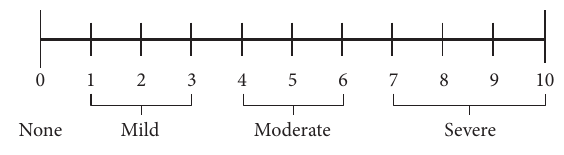
Figure 2: Numeric rating scale